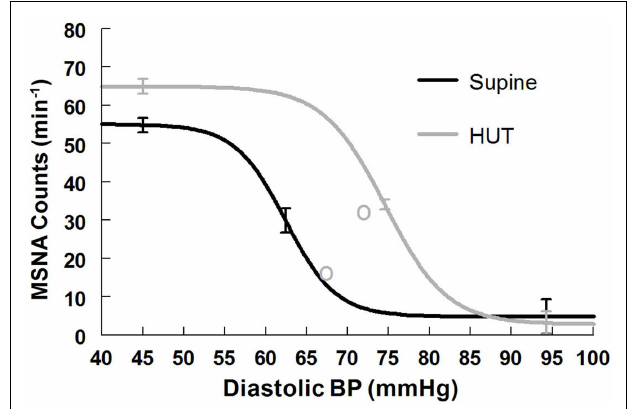
FIGURE 6 | Supine and upright MSNA burst count response relationships obtained by averaging data-fits over all subjects during the Oxford maneuver. The upright curve is shifted from supine but the maximum slope (sensitivity), response range, and saturation are also increased when